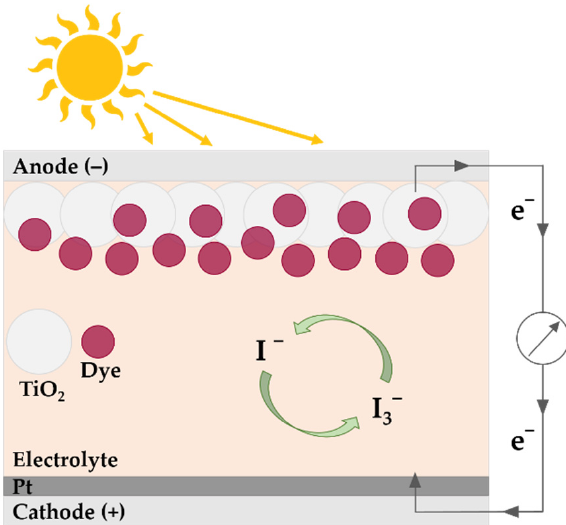
Figure 1. Schematic representation of a DSSC.